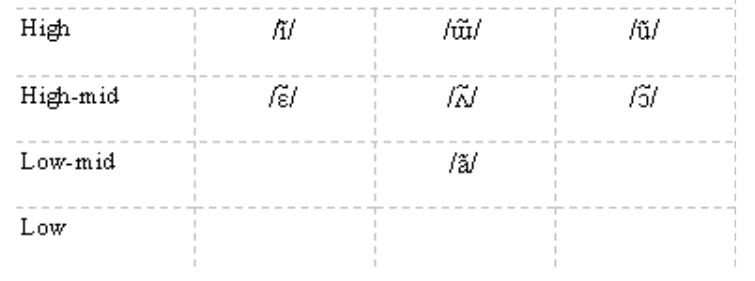
Figure 2. Acehnese nasal